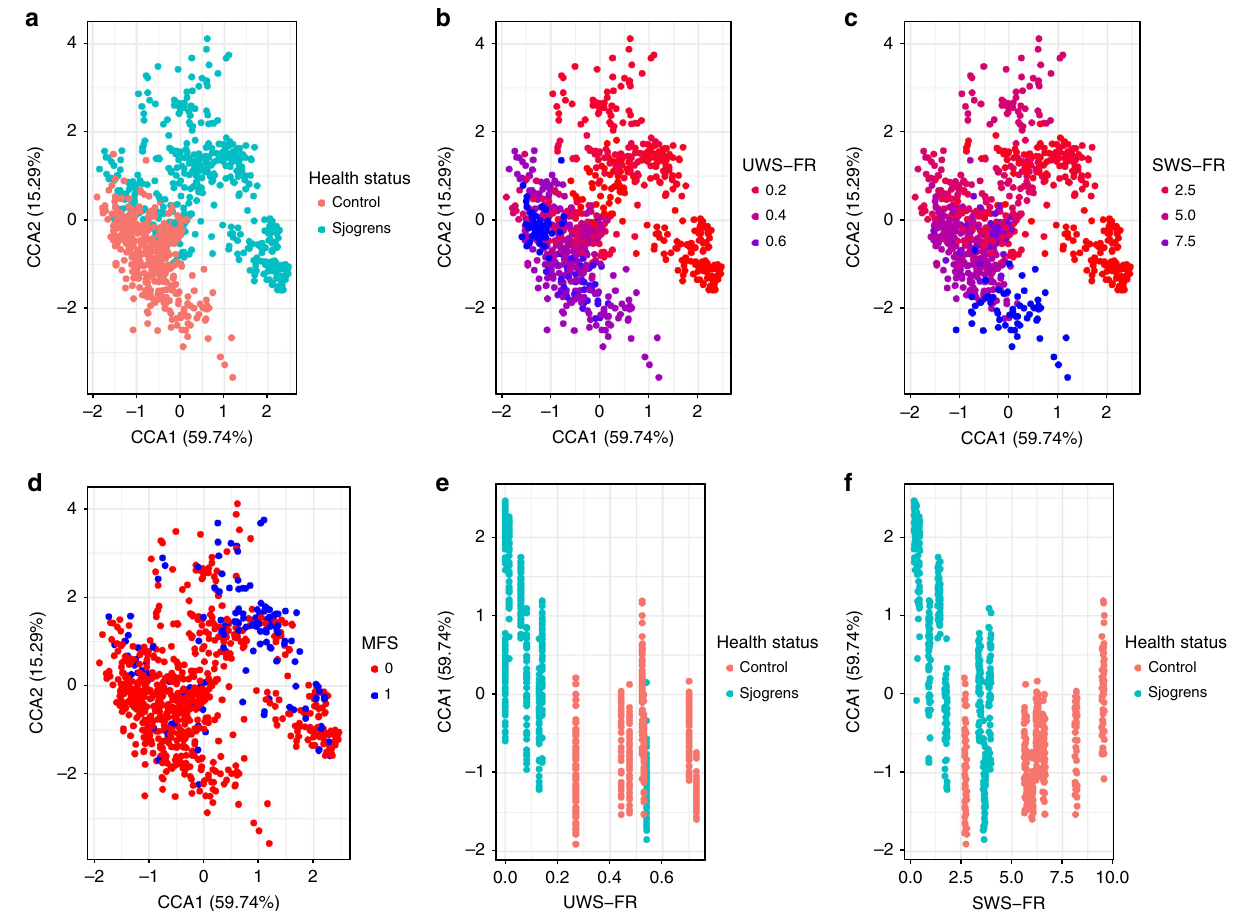
Fig. 4 Low salivary fl ow impacts the composition of microbial communities independent of past dental caries. Constrained correspondence analysis (CCA) was performed on the species × sample data matrix for the validation data set (147 taxa; 825 samples). Each point corresponds to a community sample colored by a health status (Sjögren ’ s, Control), b unstimulated whole-salivary fl ow rate (UWS-FR: 0.2, 0.4, or 0.6 mL/min), c stimulated whole-salivary fl ow rate (SWS-FR: 2.5, 5.0, or 7.5 ml/min), or d the index of missing, fi lled surfaces for smooth surface sites (MFS: 0, 1). The clustering of samples suggested that UWS-FR b and SWS-FR c explain more of the variation in the data than health status a or MFS d . To examine this explicitly, e CCA1 scores were plotted against UWS-FR, and community samples were colored according to health status of the host (Sjögren ’ s, Control). Samples from the one Sjögren ’ s patient who had a relatively high UWS-FR (~0.5 ml/min) grouped along CCA1 with control samples rather than with the other Sjögren ’ s samples. Likewise, f samples from the healthy control patient who had a relatively low SWS-FR (~2.5 ml/min) grouped along CCA1 with Sjögren ’ s samples